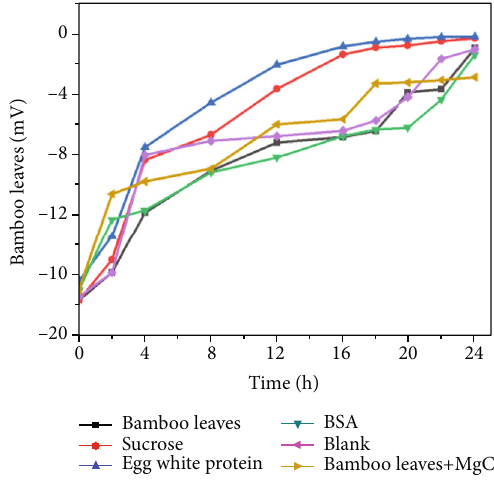
Figure 7: Zeta potential value change diagram.